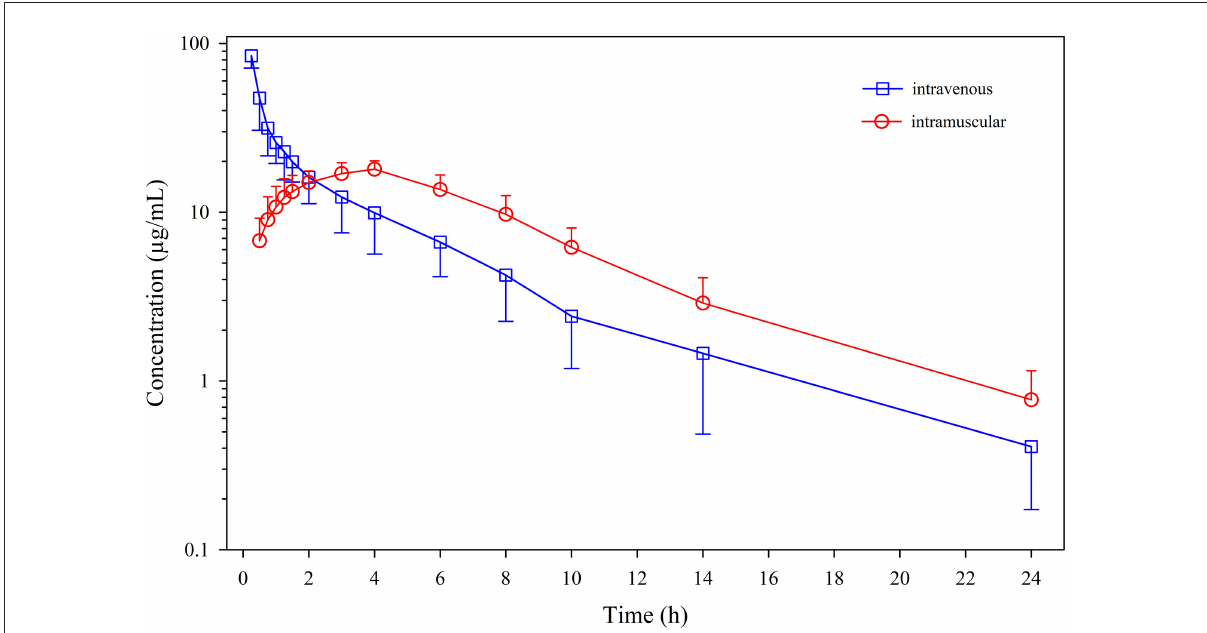
FIGURE1 Plasma concentrations (mean ± SD) of menbutone obtained after intravenous and intramuscular administration (10 mg/kg) to 12 sheep.